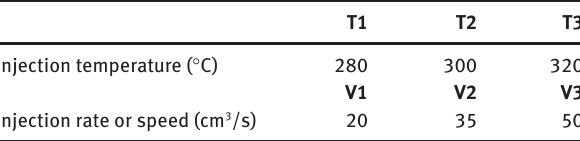
Table 6 Variable parameters of injection molding process.